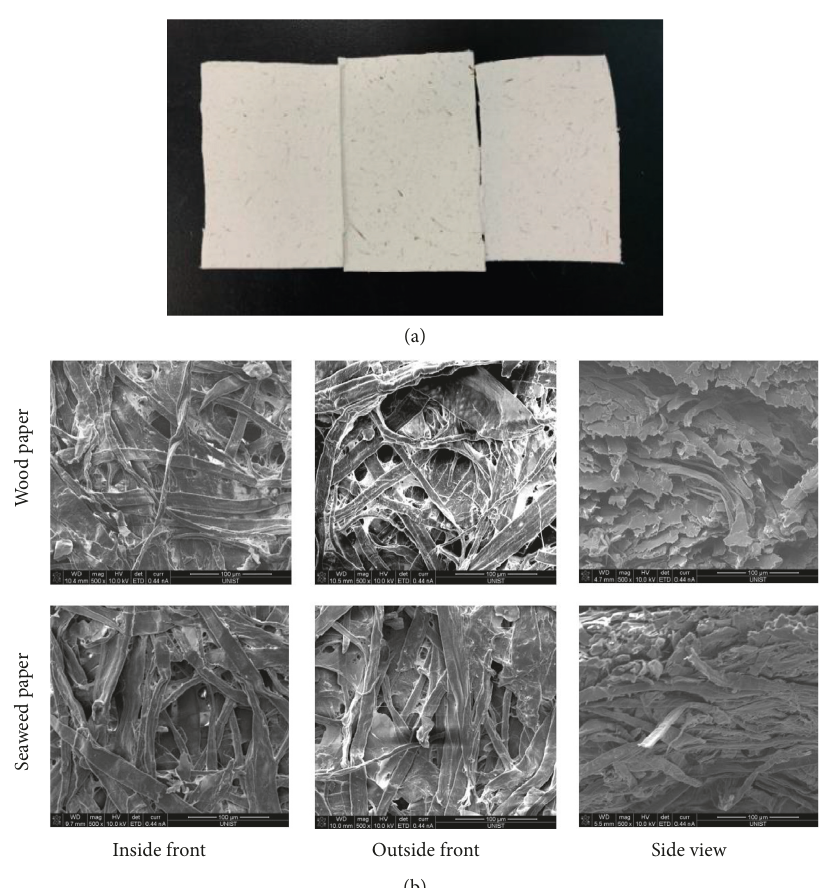
Figure 4: Appearance of synthesized film. (a) Synthesized seaweed-based biodegradable film, (b) FE-SEM image of the synthesized film: (i) inside front; (ii) outside front; (iii) side view. The magnification rate is 500 for all